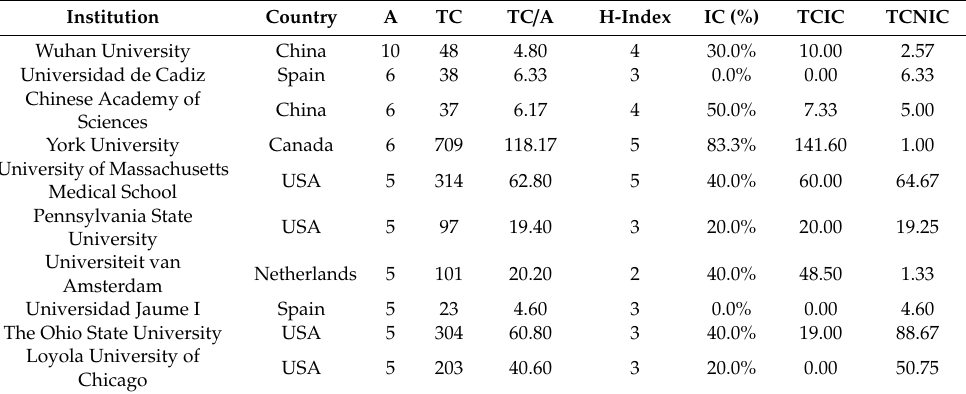
Table 6. The most productive institutions in number of articles